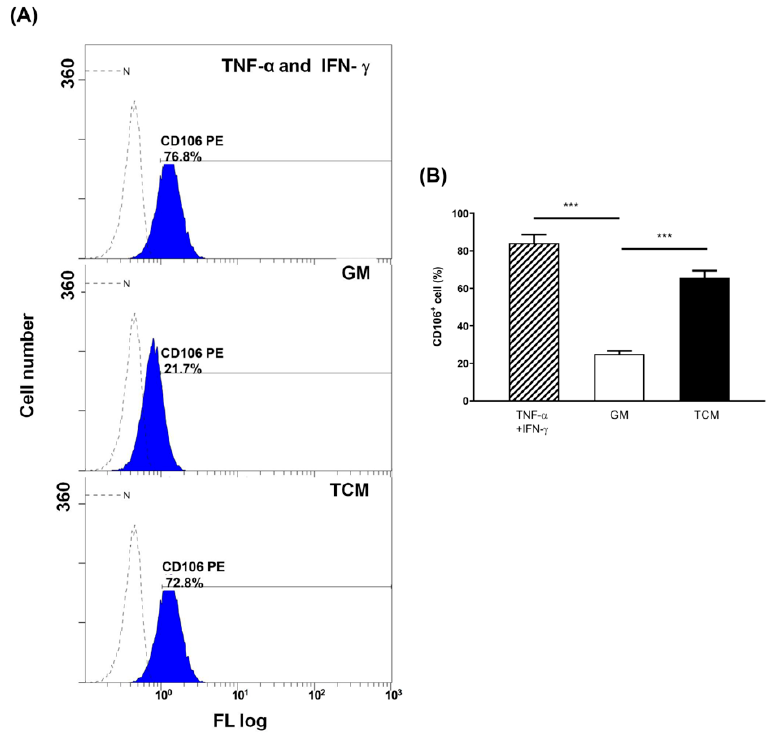
Figure 6. TCM increases endothelial VCAM-1 expression. VCAM-1 (CD106) on TCM-stimulated 2H11 EC were determined by flow cytometry. ( A ) Representative flow cytometry histograms of CD106 expression (blue peak) versus the corresponding isotype control (dashed line) on 2H11 EC. ( B ) Percentage of C106+ cells induced by TCM treatment (“TCM”) was compared to control cells in growth medium (“GM”) in three individual experiments. “TNF- α and IFN- γ ”: cytokine treatment of tumor necrosis factor- α (TNF- α ) and Interferon- γ (IFN- γ ) as positive control to GM. Mean ± SEM; ***: p < 0.001 by t-test.